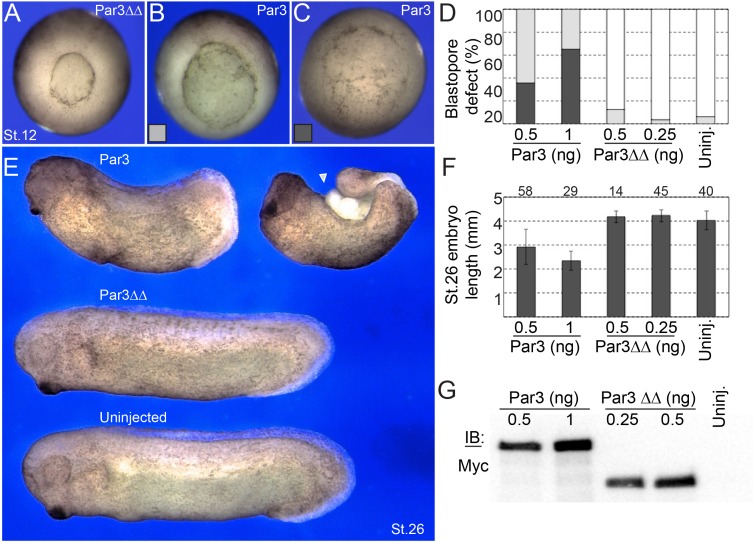
The ability of Par3 to inhibit blastopore closure and body axis elongation is lost upon the disruption of Pk3 binding.Four-cell stage embryos were injected with Par3 constructs into the marginal zone of two dorsal blastomeres. (A–C) Vegetal views of stage 12 (St. 12) embryos injected with Par3∆∆ RNA (A, 0.5 ng), and wild type Par3 RNA (B, C, 0.5 ng). (D) Frequencies of mild (B) and severe (C) blastopore defects. (E) Representative images of stage 26 (St. 26) embryos injected with Par3 (0.5 ng) and Par3∆∆ (0.5 ng) RNAs. Par3-expressing embryos were shortened (top left) and often exhibited protruding endoderm due to incomplete blastopore closure (arrowhead). By contrast, Par3∆∆-injected embryos were similar to uninjected embryos. (F) Average length of embryos ± s. d. is shown. (G) Comparison of Par3 protein levels in injected stage 12 embryos by immunoblotting with anti-Myc antibodies. Each sample has been pooled from five embryos. Each lane was loaded with lysate amount equivalent to half-embryo.